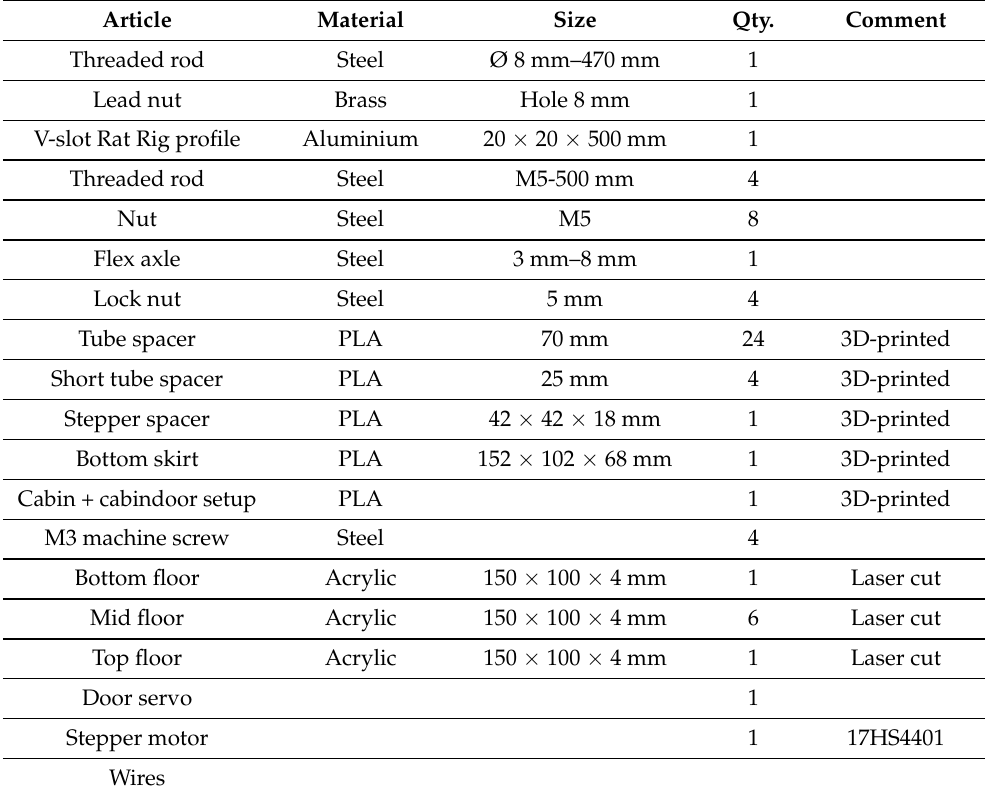
Table 4. Mechanical components for the elevator